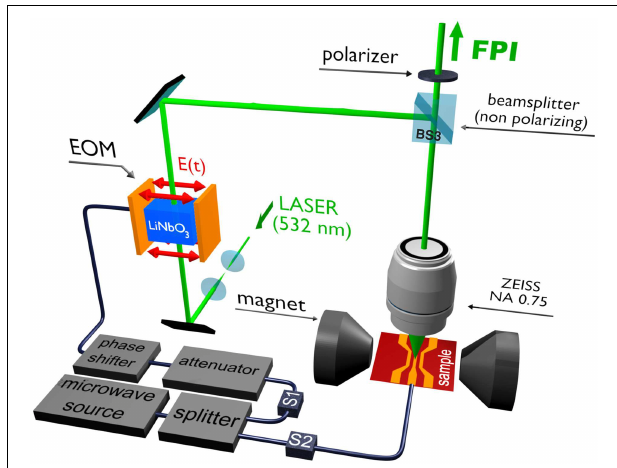
FIGURE 11 | Scheme of the experimental setup for realizing phase-resolved BLS microscopy. The signal generated by a microwave source is split. One branch is guided to the sample where the associated dynamic magnetic field excites spin waves, the second branch drives an electro-optical modulator generating a reference light of constant phase. The interference of the light inelastically scattered on spin waves and the light generated by the electro-optical modulator is used to retrieve the phase information of the excited spin waves.